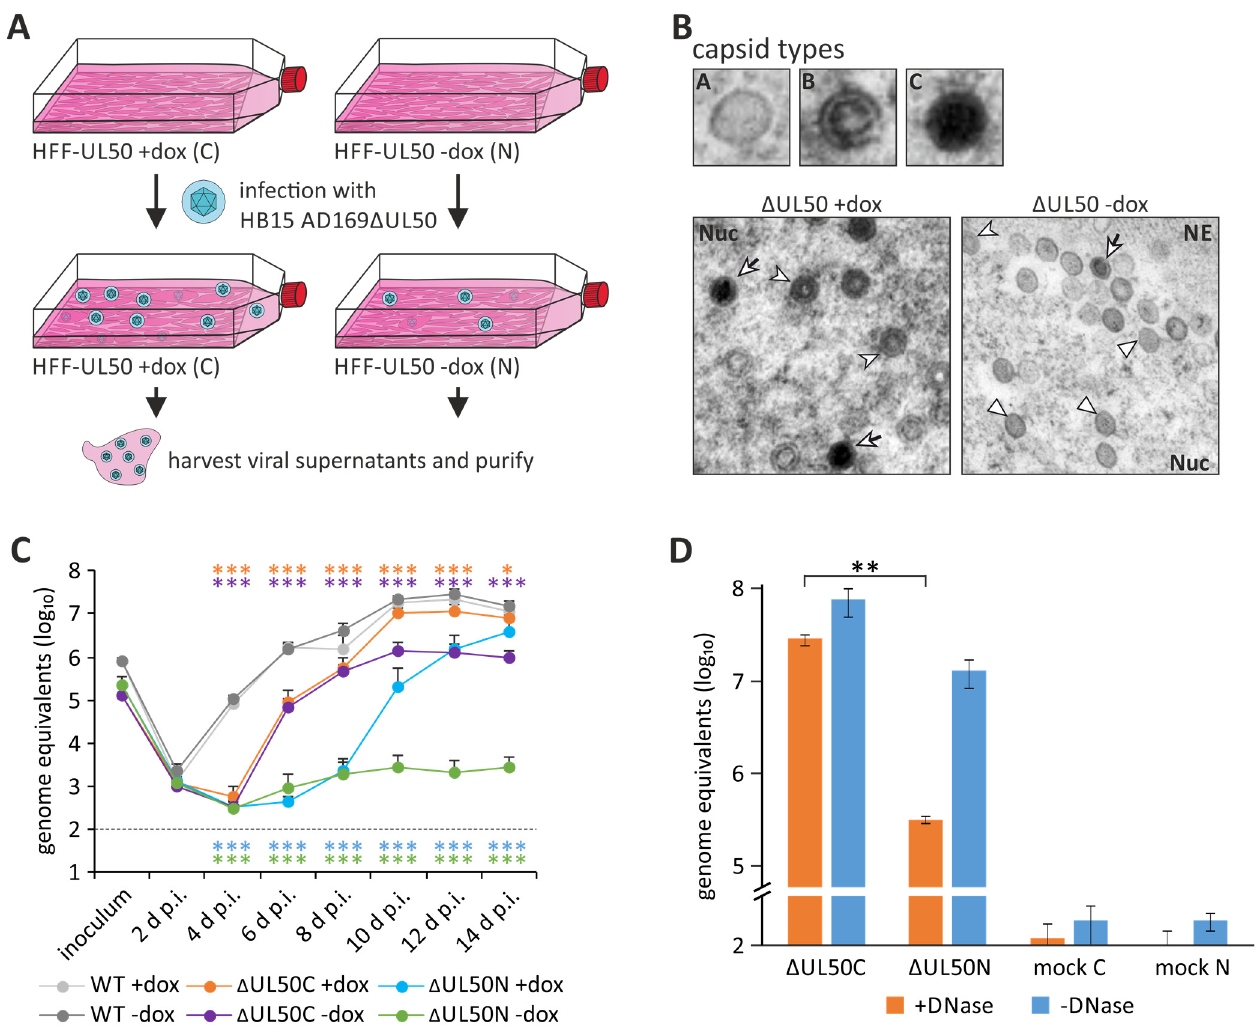
Figure 7. Generation and the phenotypical features of the ∆ UL50 virus. ( A ) Schematic depiction of the purification of ∆ UL50 particles. HFF-UL50 cells, either dox-induced (+dox) or uninduced ( − dox) were infected with HCMV ∆ UL50. Viral supernatants were harvested and purified, ∆ UL50 particles derived from pUL50-complementing conditions were named ∆ UL50C and from non-complementing conditions ∆ UL50N. ( B ) Transmission electron microscopy (TEM) ∆ UL50C-infected HFF-UL50 cells, either induced or uninduced, reveals a strong accumulation of immature A capsids (white triangle) and reduction of mature C capsids (white arrowhead with black tail) under the non- complementing condition; white arrowhead, B capsids. ( C ) Replication kinetics of the ∆ UL50C and ∆ UL50N particles on complementing or non-complementing cells showing a strong impairment of replication efficiency in the absence of co-expressed pUL50. Statistical significance of the values of genome equivalents was calculated by ANOVA (*, p ≤ 0.05; **, p ≤ 0.01; ***, p ≤ 0.001) for 2–19 d p.i. in relation to WT (mean value of WT +dox and WT − dox). ( D ) Comparison of viral genome levels in ∆ UL50C and ∆ UL50N particles by DNase treatment revealing strongly reduced levels of packaged viral genomes in the ∆ UL50N particles. Statistical significance was calculated by the Student’s t -test (**, p ≤ 0.01) (modified from [28,103] ). 6.2. Regulated Viral Nuclear Egress Compared to Nuclear Envelope Breakdown (NEBD) The herpesviral egress is required to overcome the physico-chemical barrier of the NE (represented by nuclear lamina, INM, ONM and NPCs). This nucleocytoplasmic capsid transport is a specifically regulated process as described in chapter 1. In comparison to this, the cellular nuclear envelope breakdown (NEBD) is a well-studied